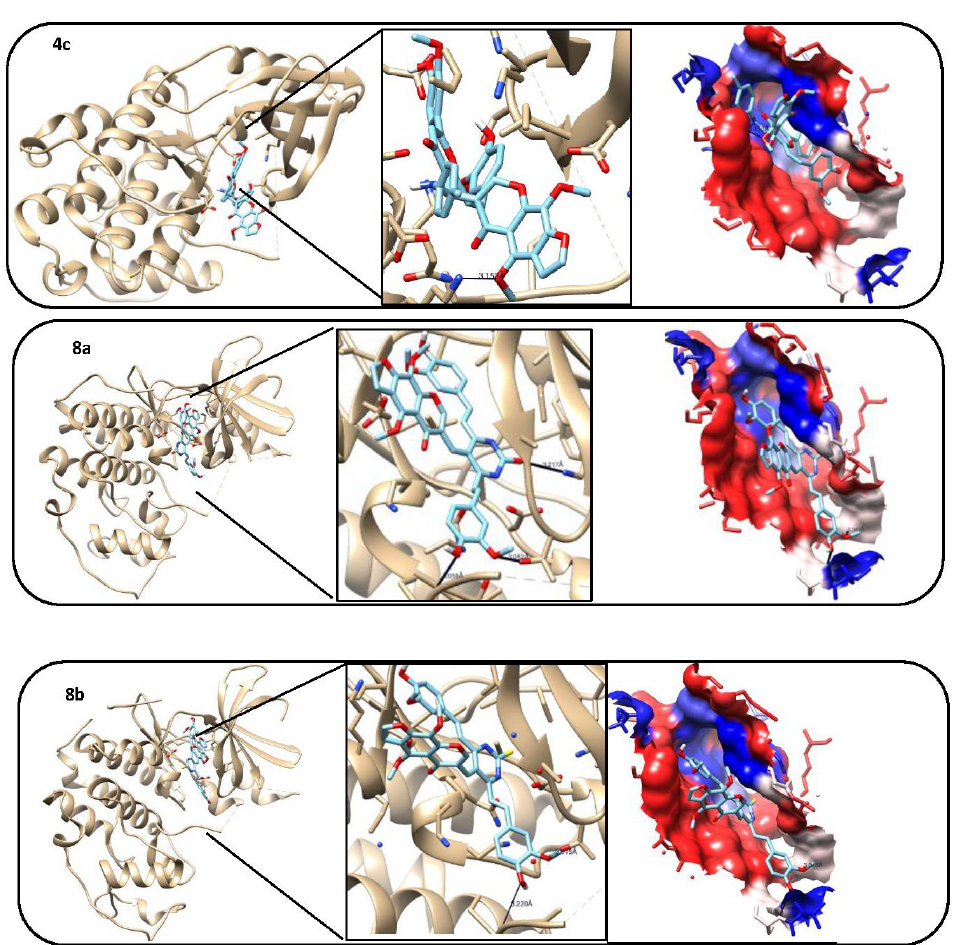
Figure 5. 3D model, hydrogen bond formation, and hydrophobic interaction between tested compounds ( 1 , 2 , 4b , 4c , 8a and 8b ) and cyclin dependent Kinase 2 (CDK2) protein. Table 3. The hydrophobic interactions of best conformer with 1di8 receptor. Compound